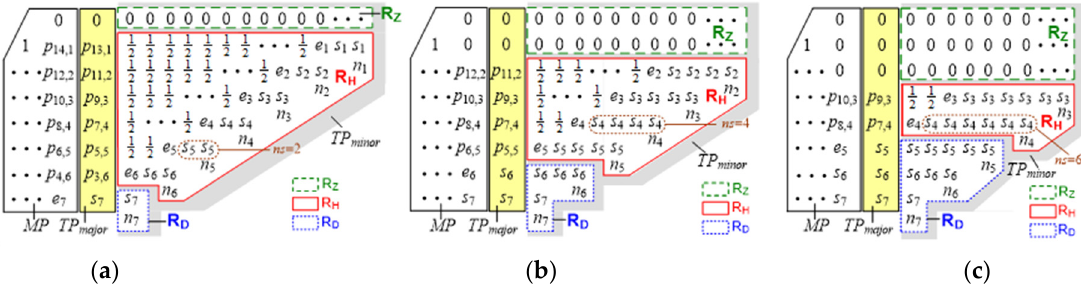
Figure 2. Schematic for the TP minor contents in a P . P . array of a 16-bit Booth multiplier for various L ′ -bit input patterns: ( a ) L ′ = 14, ( b ) L ′ = 12, and ( c ) L ′ = 10